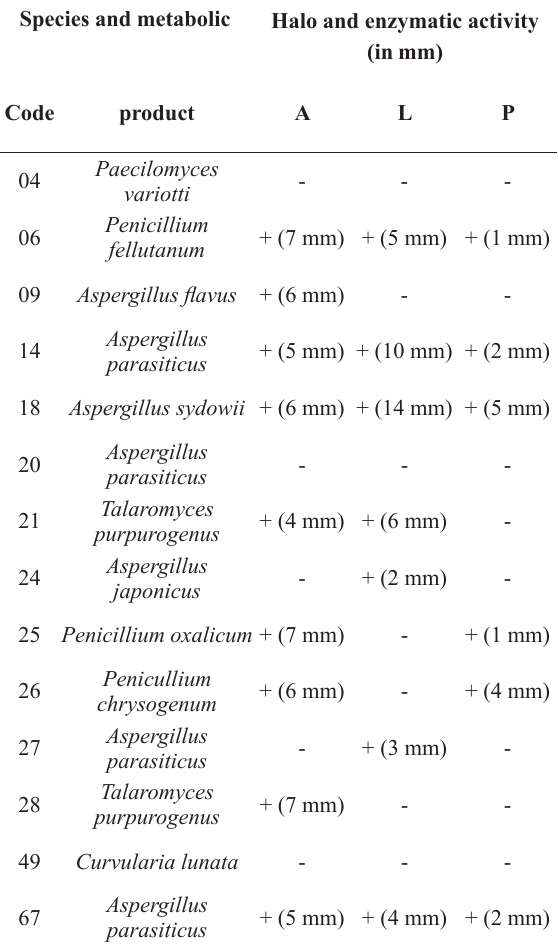
Identification of the species and metabolic product of fungi isolated in the air of the CAV/UFPE and halo of enzymatic activity (in